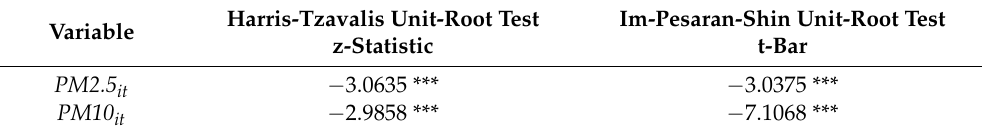
Table 3. Unit root test for key variables.